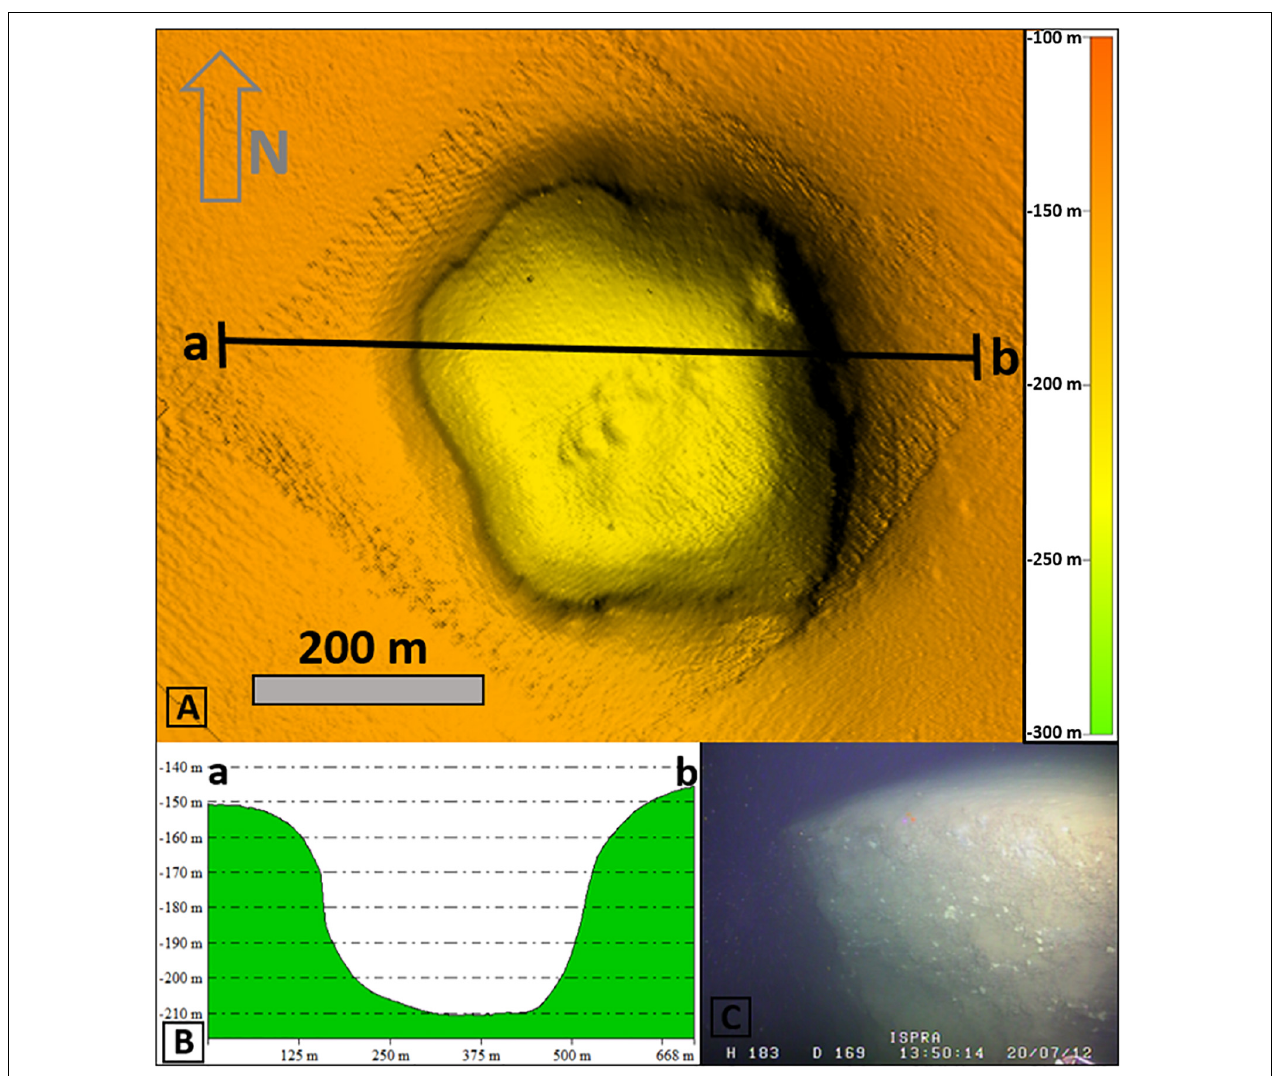
FIGURE 3 | (A) High-resolution shaded-relief image displaying a large pockmark south of the Terribile Bank (location in Figure 2 ). (B) Bathymetric profile across the pockmark well displays its sub-vertical and deep walls imaged in the ROV photo of (C)